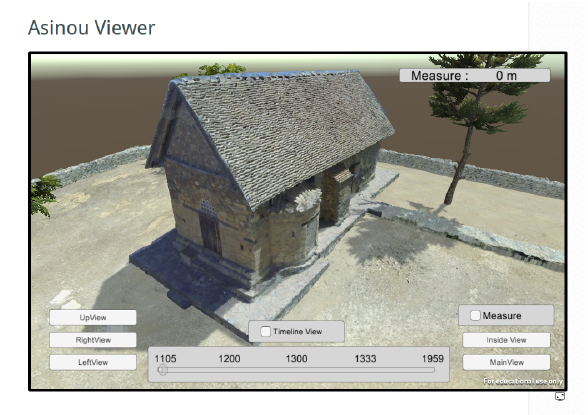
Figure 4: Implementation of the Photogrammetric Model of the Asinou Church in a Virtual